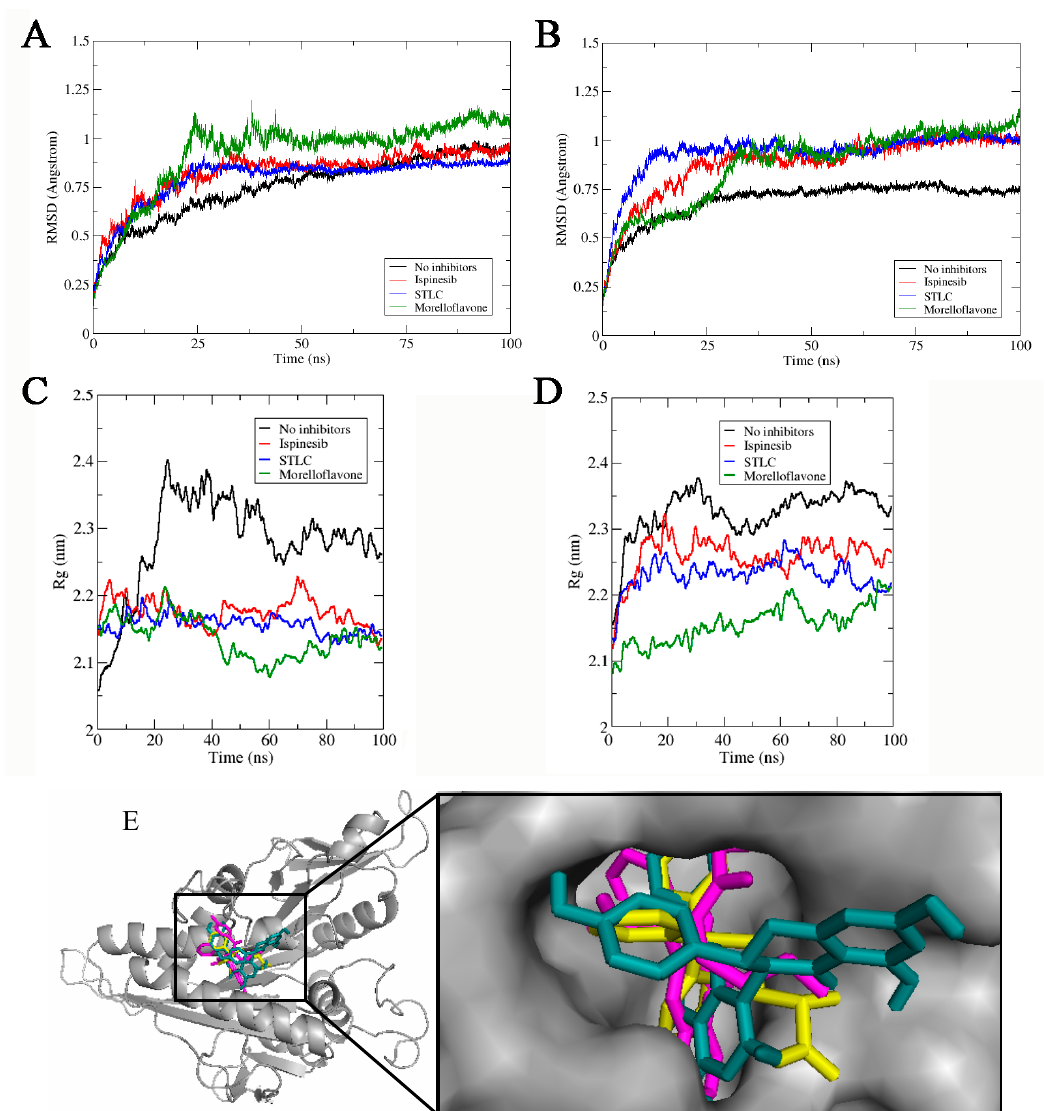
Figure 3. Stability and compactness of Eg5 complexes. RMSD of complexes in the presence of ( A ) ADP, and ( B ) ATP. Rg values of complexes in the presence of ( C ) ADP and ( D ) ATP. ( E ) MF (green stick), STLC (yellow), and ispinesib (magenta) are stably resident within the loop5/ α 2/ α 3 binding pocket.